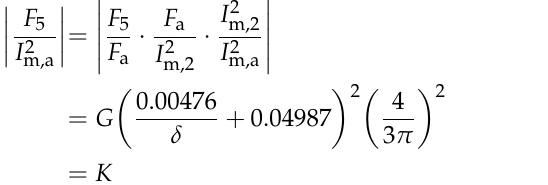
Figure 9. Experimental results and the fitted curve for F 5 ~ I m,a.